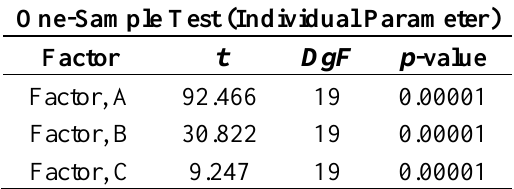
Table 5. t -Test result for testing the significance of individual